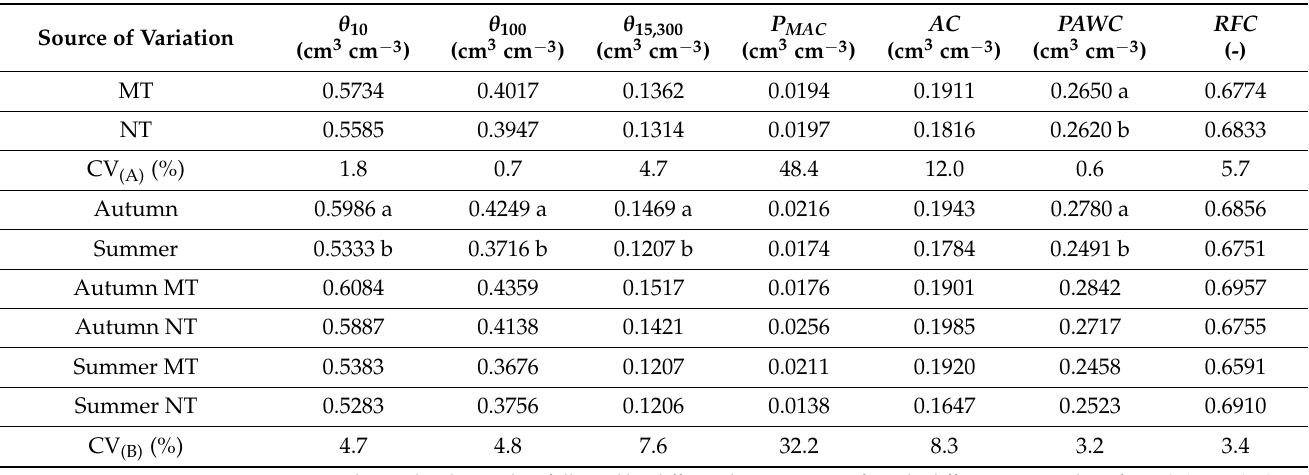
Table 3. Mean separation and coefficients of variations of volumetric soil water contents ( θ 10 , θ 100 , θ 15,300 ) and capacity-based indicators.